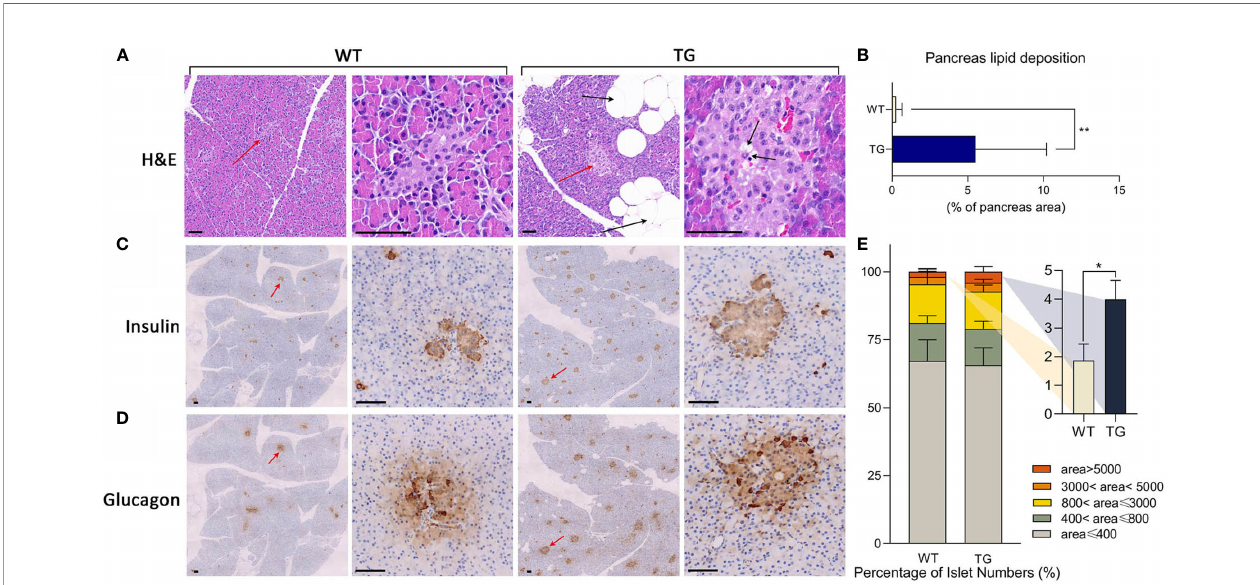
FIGURE 2 | Histological analysis of pancreas. (A) Representative images of pancreas HE staining. Islets were pointed out by red arrows and presented in the second and the fourth column. Lipid drops were pointed out by black arrows. Scale bars, 50 m m. (B) Statistics of the percentage of lipid deposition in the pancreas. (C, D) Immunohistochemical staining of insulin (C) and glucagon (D) in two continuous sections. Islets were pointed out by red arrows and presented in the second and the fourth column. Scale bars, 50 m m. (E) Statistics of islet area by insulin staining. *P < 0.05, **P <